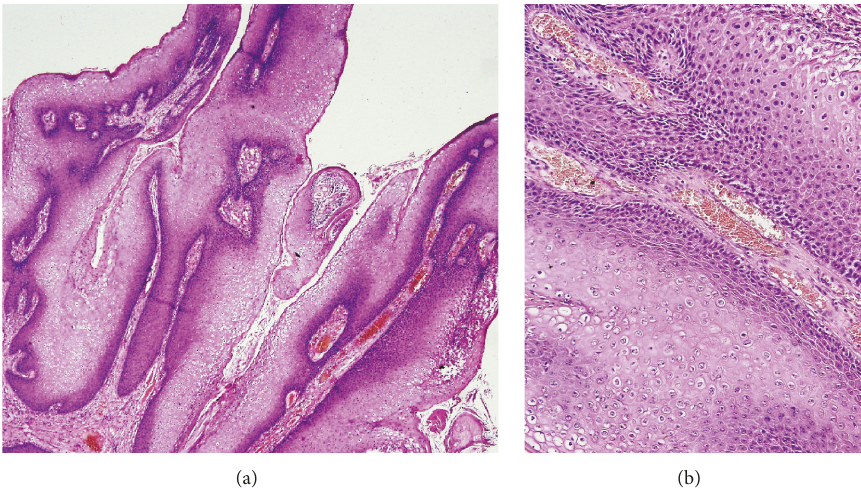
Figure 4: Histology of giant condyloma of Case 1. (a) x4 magnification (b) x20 magnification.